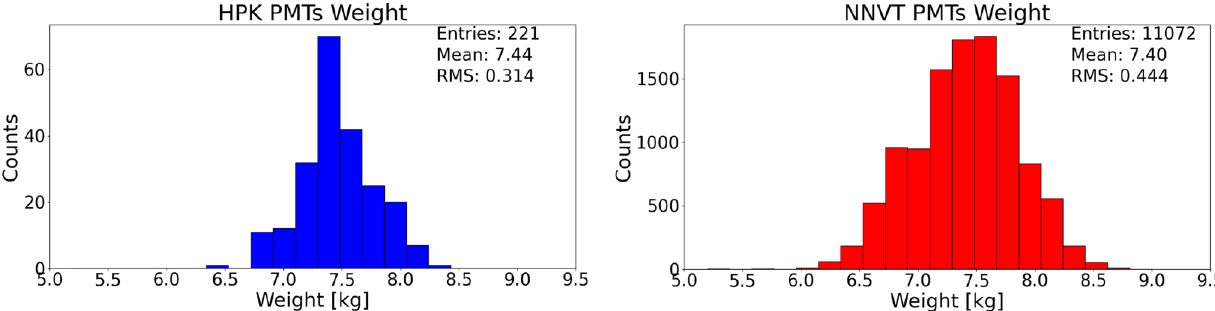
Fig. 9 Measured weight in kg of all checked 20-inch PMTs. Weighing was performed only with a sub-sample of all PMTs. Left: HPK; right: